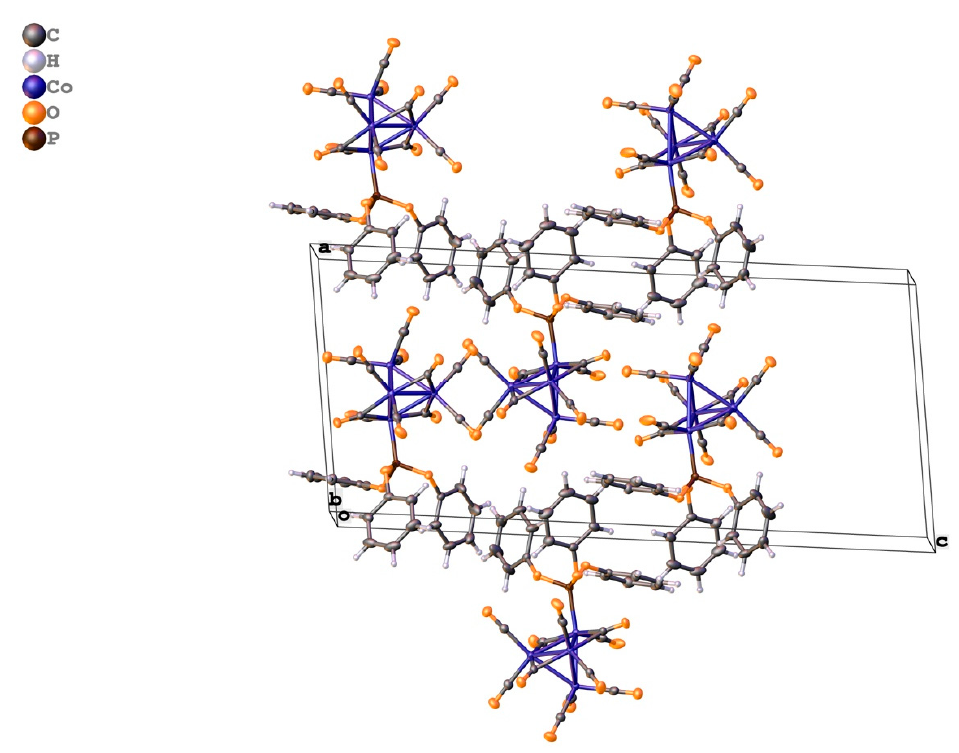
Figure 6. OLEX-generated view of the packing of 2 along the a axis.